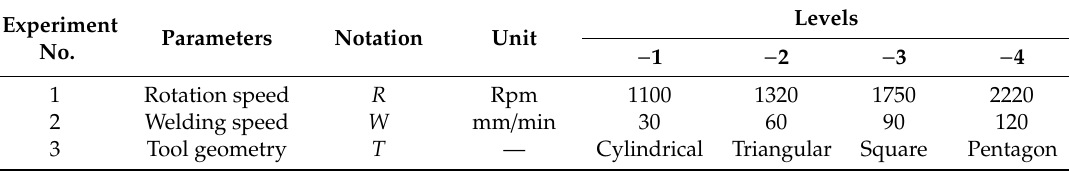
Table 3. The FSWp of parameters and its levels.